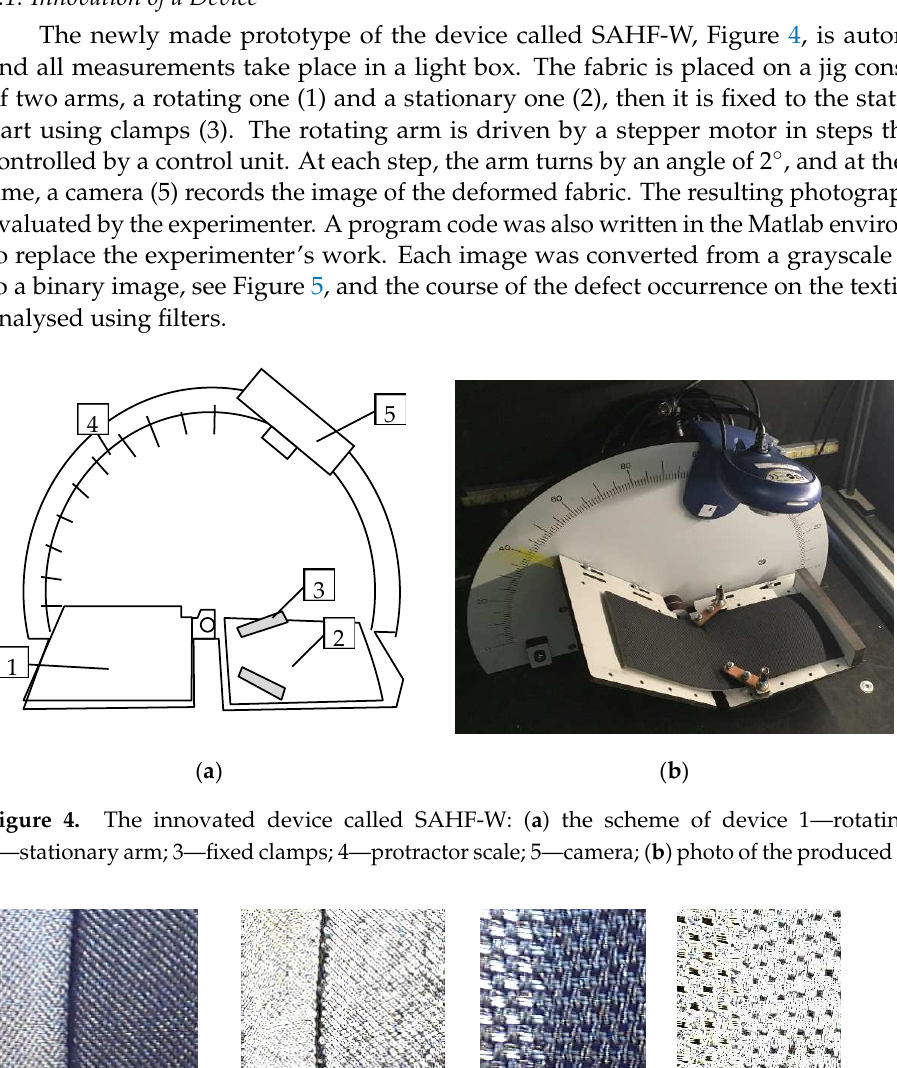
Figure 5. Textile with a defect evaluated using the image analysis method: ( a , b ) fabric with a smooth pattern; ( c , d ) fabric with an unsmooth pattern.